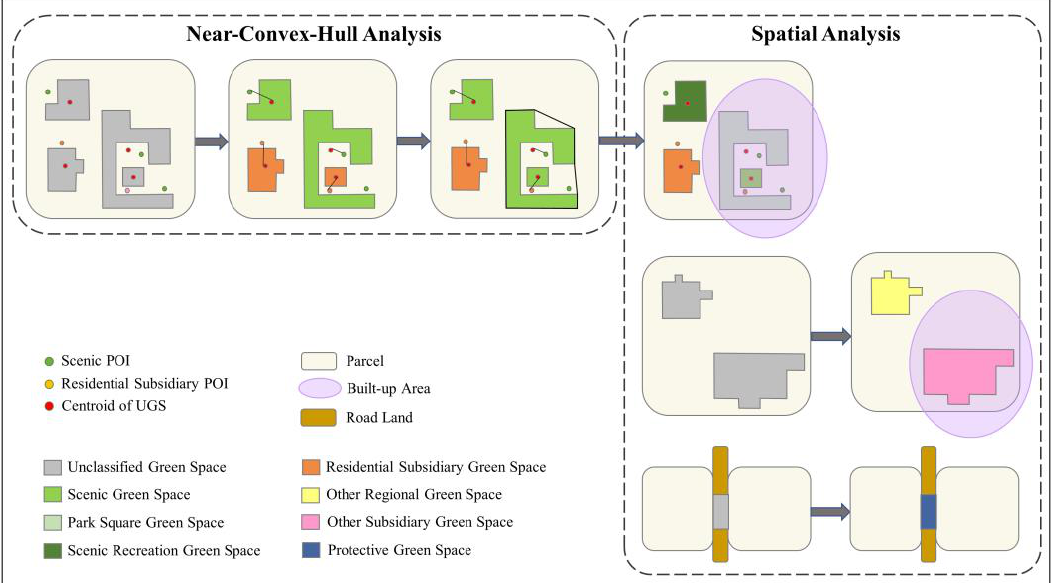
Figure 4. Overview of the framework for functional classification of UGS.